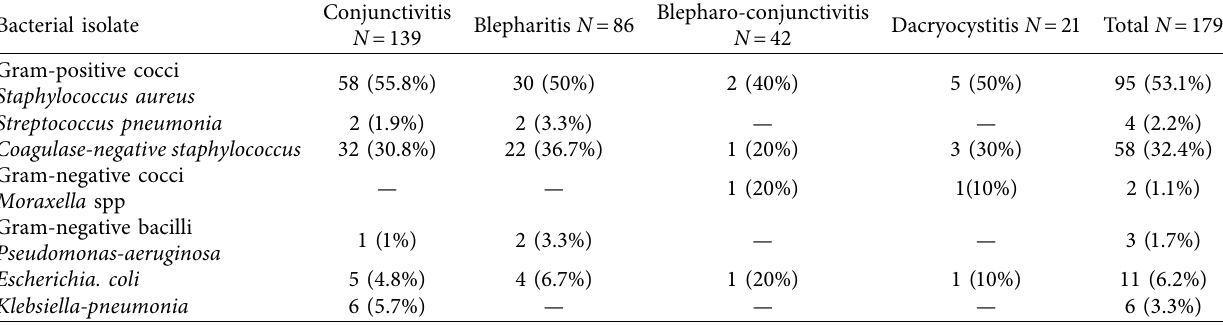
Table 3: Bacterial profles among diferent clinical features of external ocular infection attending at Karamara hospital, Jigjiga, eastern Ethiopia, 2020.